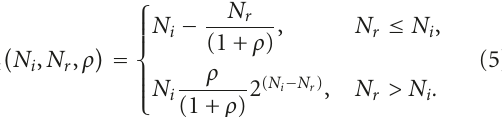
Number of input symbols:100, parity ratio: 0 . 5 (zoomed around N r = N i )